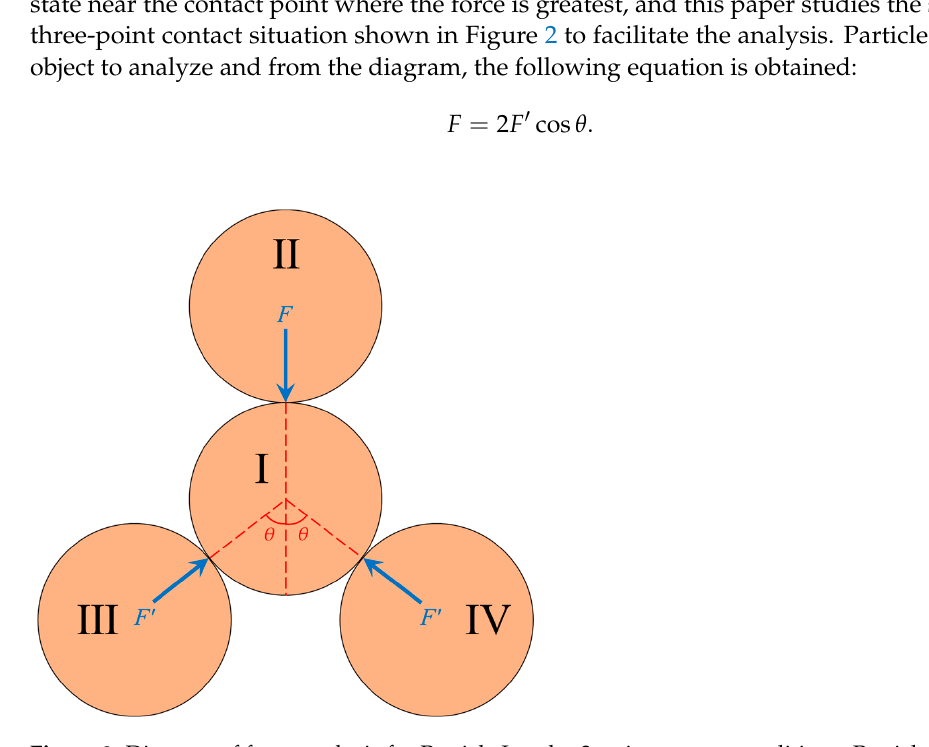
Figure 2. Diagram of force analysis for Particle I under 3-point contact conditions. Particles III and IV are symmetrical about the plane passing through the center of Particle I and perpendicular to the paper. θ is the angle between the central line of Particles I and III/IV and the axis of